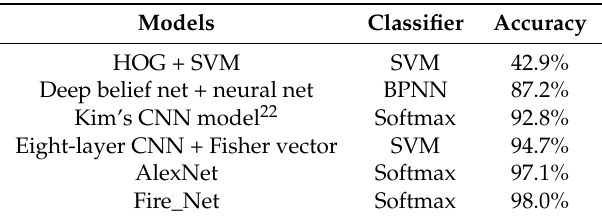
Table 8. Comparison of Fire_Net with other methods.